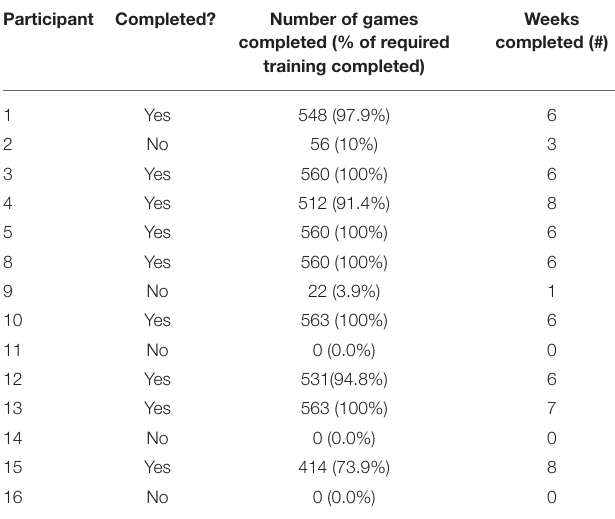
TABLE 2 | Executive functioning training